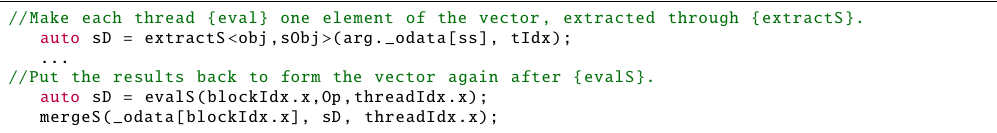
Figure 2. Comparison of OpenACC SU(3) streaming bandwidth with and without coalesced